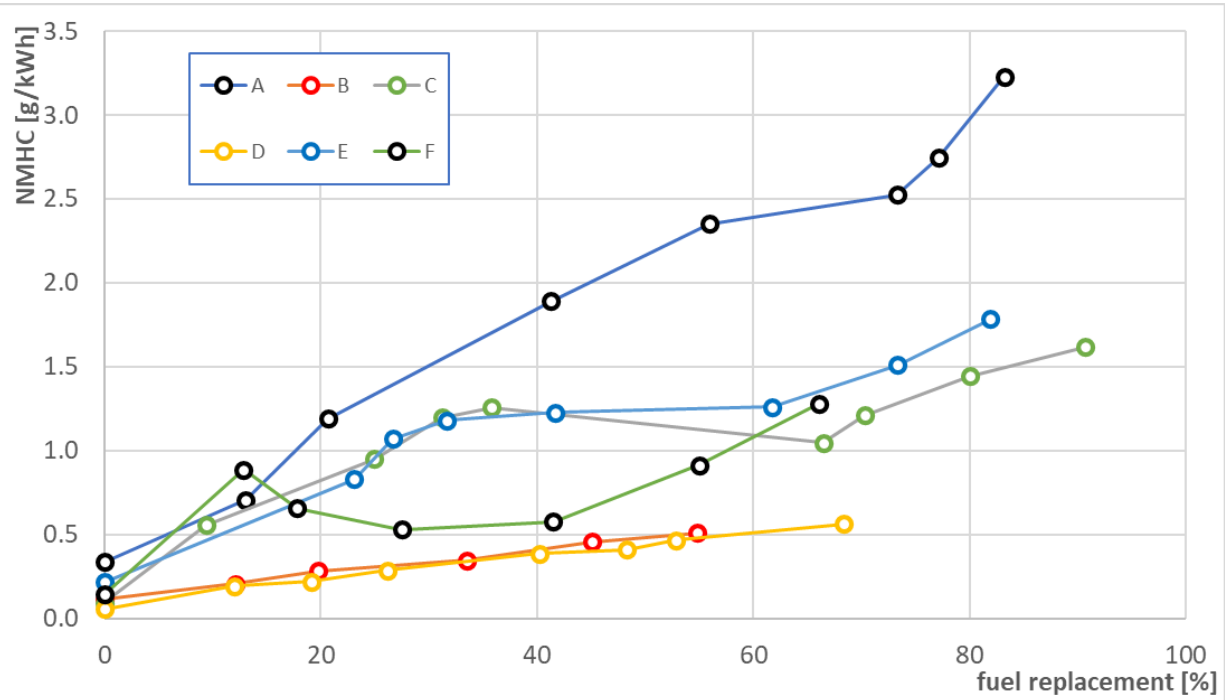
Figure 15. Curves from A to F showing engine’s emission of NMOC (Non-Methane Organic Com- pounds), for individual engine operating points, where the rotation speed, power, and torque were constant, as a replacement function of diesel fuel replaced by CNG.